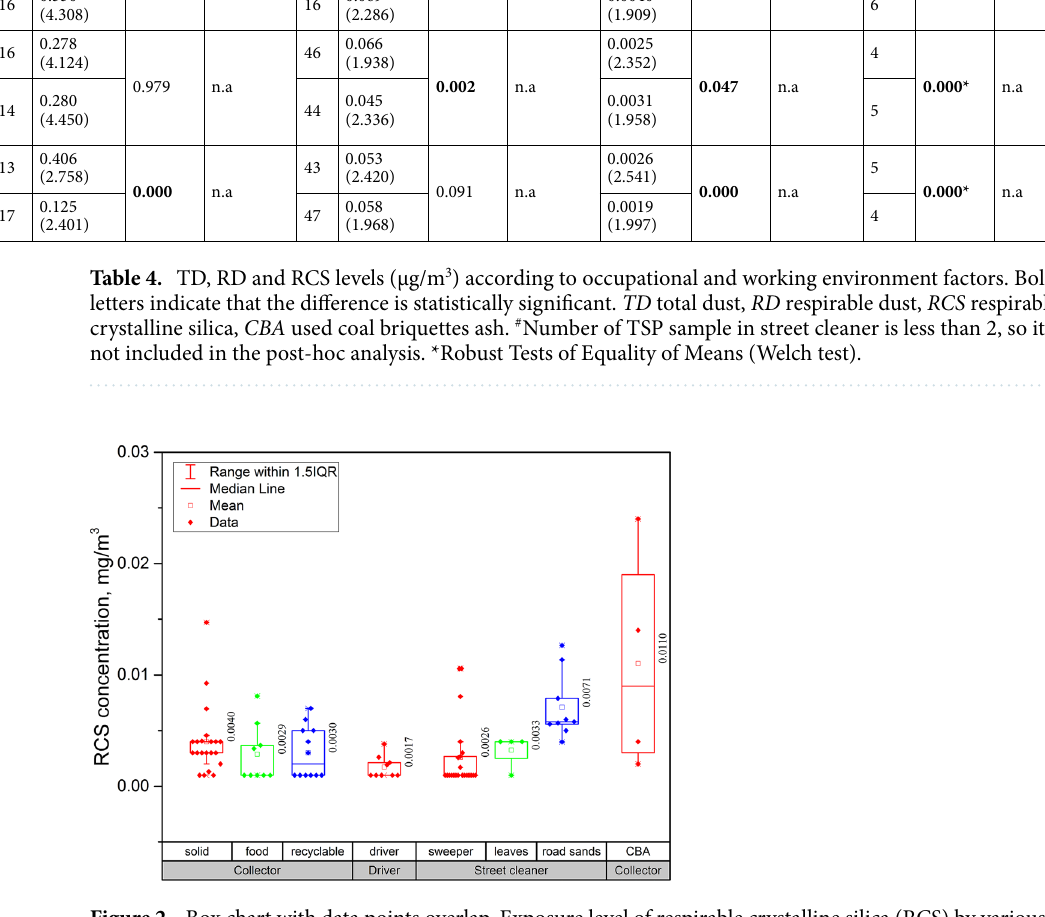
Figure 2. Box chart with data points overlap. Exposure level of respirable crystalline silica (RCS) by various tasks. Cleaning of fallen leaves and road sand uses a